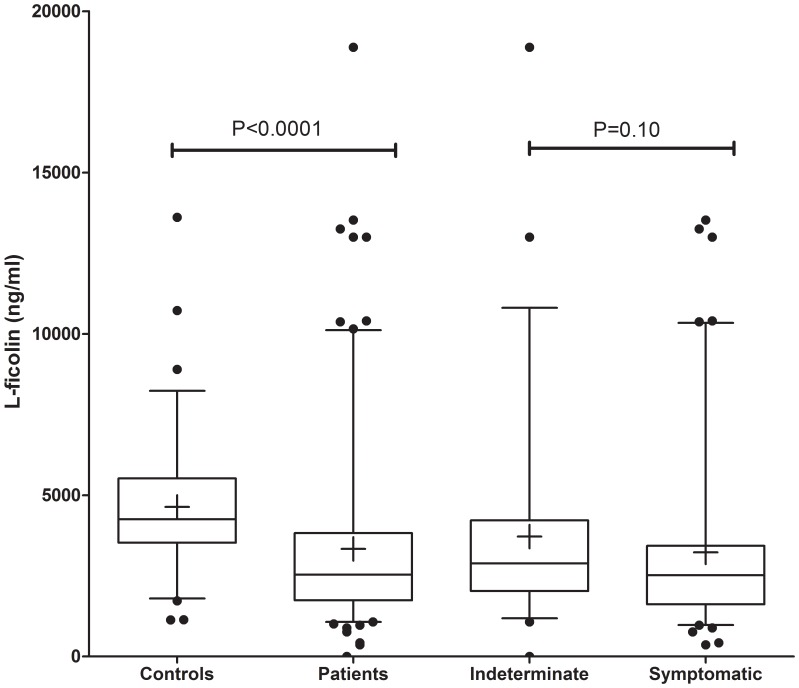
L-ficolin levels in Chagas patients and controls.The statistical distribution is shown with median (line in the box), box indicating the 25–75 percentiles, whiskers the 5–95 percentile and arithmetic mean (cross inside the box).